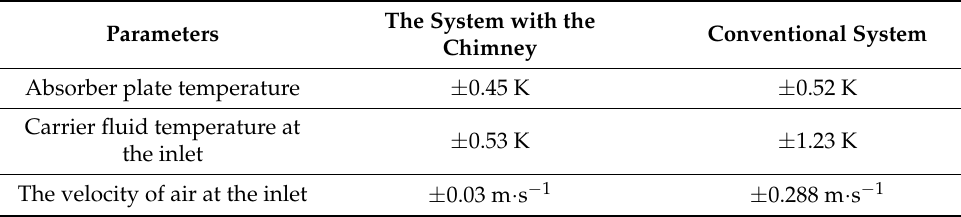
Table 3. Experimental uncertainties in the